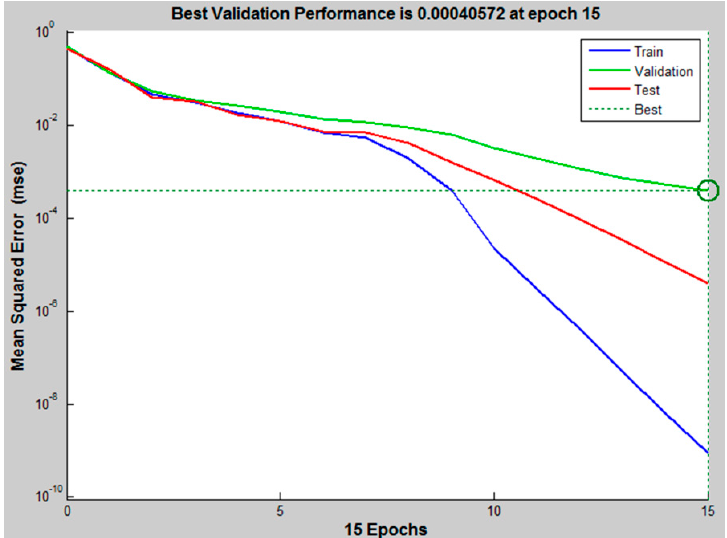
Figure 9. The training result of the BP neural network model.